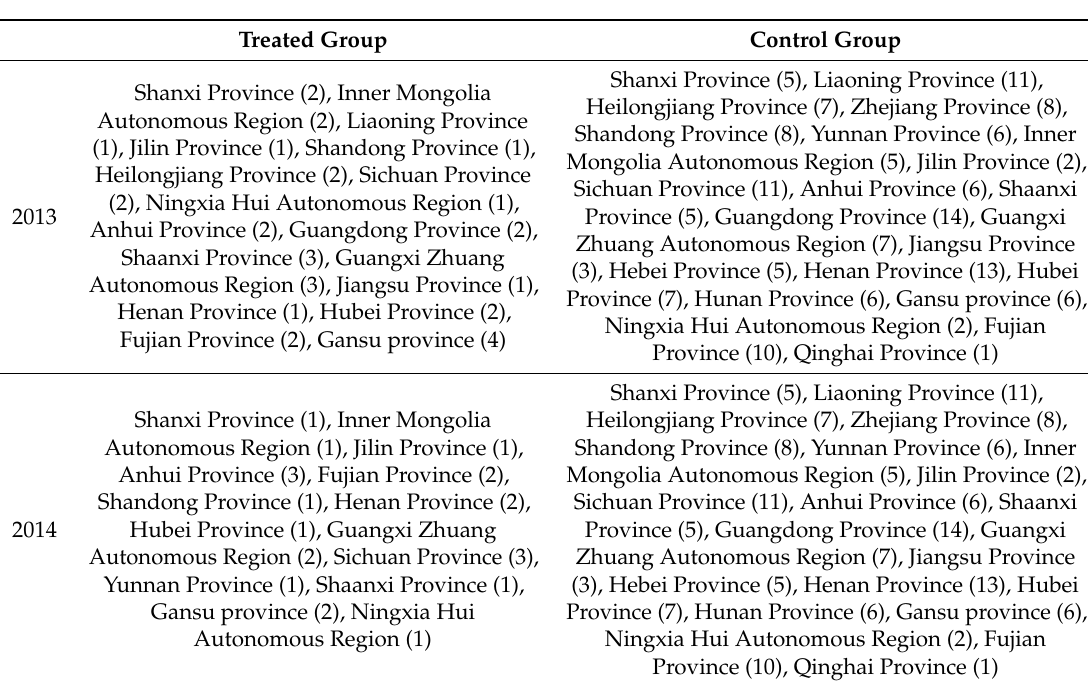
Table A1. Distribution of smart